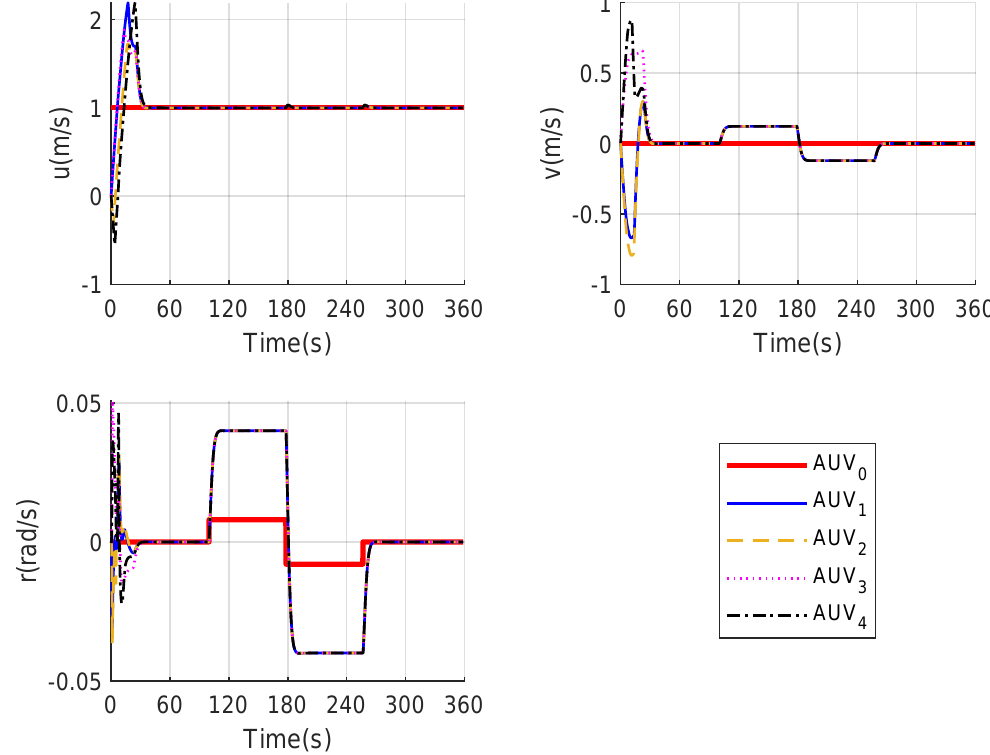
Figure 6. Velocity states of multi-AUV under ideal communication topology without